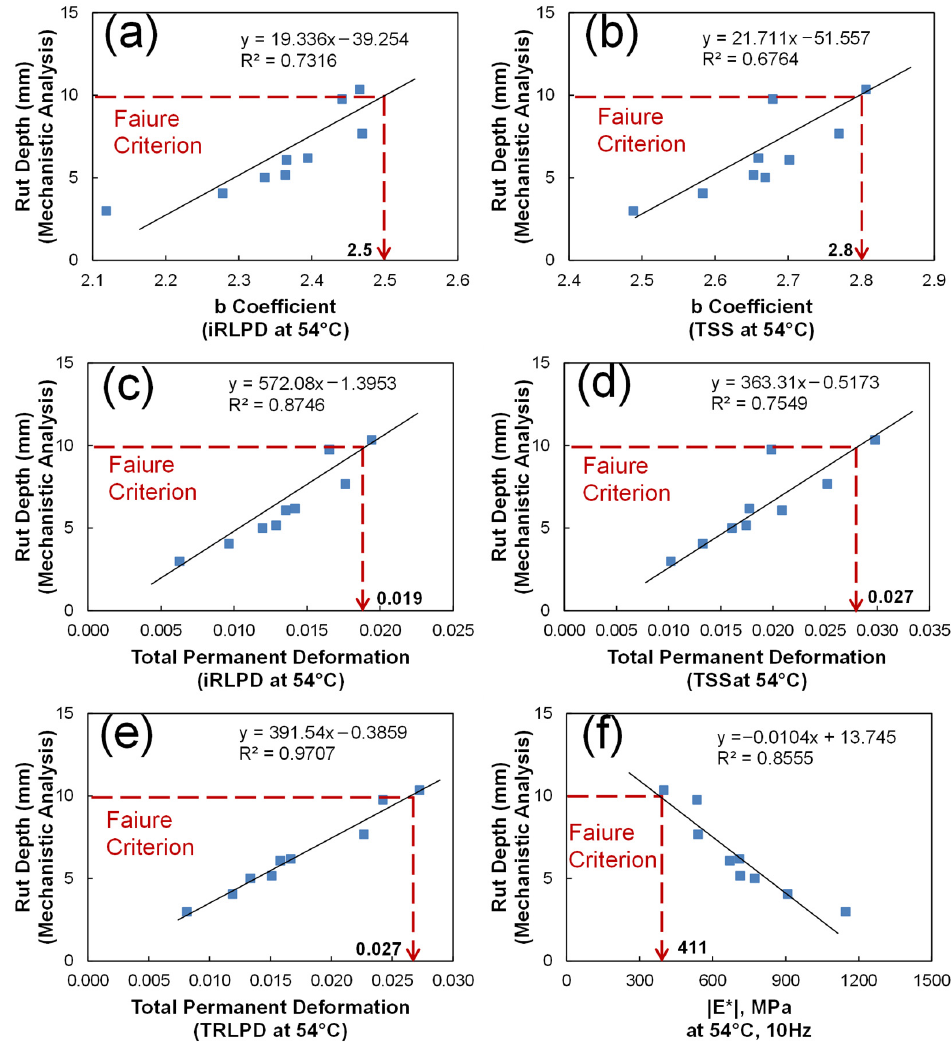
Figure 15. Identi fi cation of the optimal ru tt ing index and its performance threshold values: b Coef- fi cient ( a ) iRLPD, ( b ) TSS; Total permanent deformation at: ( c ) iRLPD, ( d ) TSS, ( e ) TRLPD; |E ∗ | : ( f ). Relationships between the e ffi cient performance indices and predicted mechanistic performance were compared in the same way as the volumetric AQC-predicted perfor- mance linear models as expressed in Figure 16. The results show that the model form of fatigue index is a power function, whereas that of ru tt ing index is a linear function. The ru tt ing index has a stronger relationship with the mechanistic performance rather than the fatigue index. Similar to the sensitivity of the design VMA on the mechanistically pre- dicted performance, the design VMA is also more sensitive on the fatigue index at the design air voids of 4 and 5%, even though it is more sensitive on the ru tt ing index at 3 and 4%. These volumetric or mechanical AQCs-predicted mechanistic performance mathe- matical models provide guidance on the extent in which the design VMA or performance indices need to be adjusted in order to reach the speci fi c performance targets at the time of construction during production.